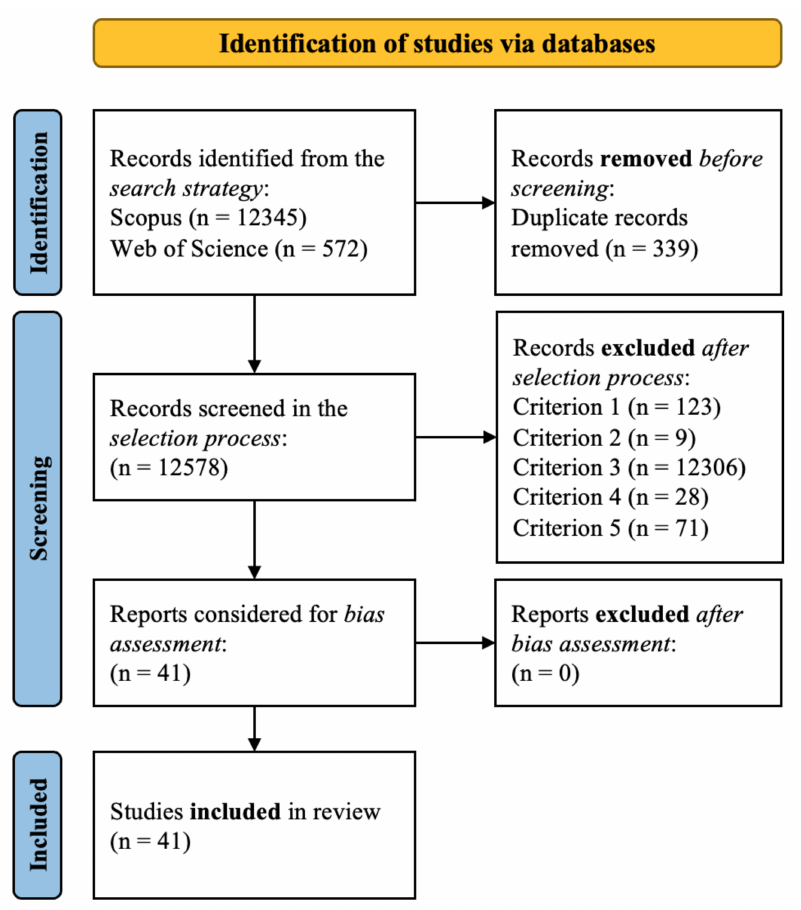
Figure 2. Identification of studies from